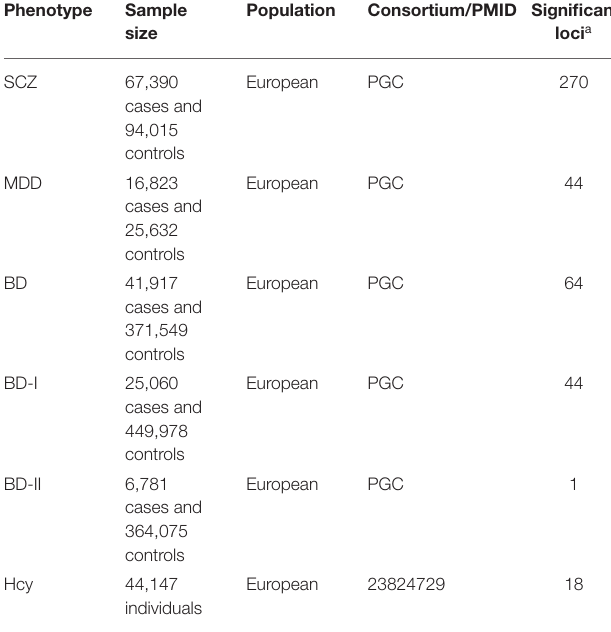
TABLE 1 | Description of GWAS summary statistics used for each